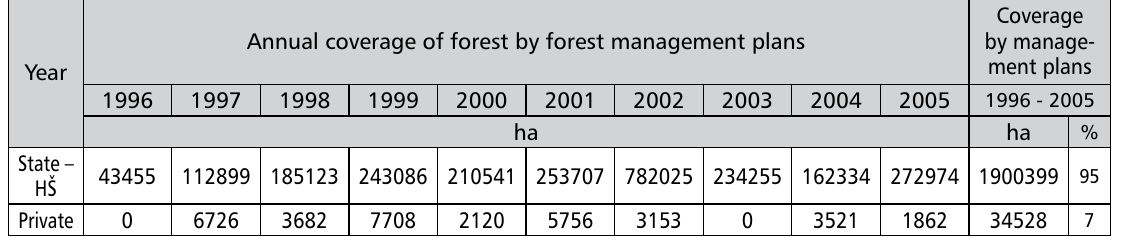
Annual coverage of forest by forest management plans (source